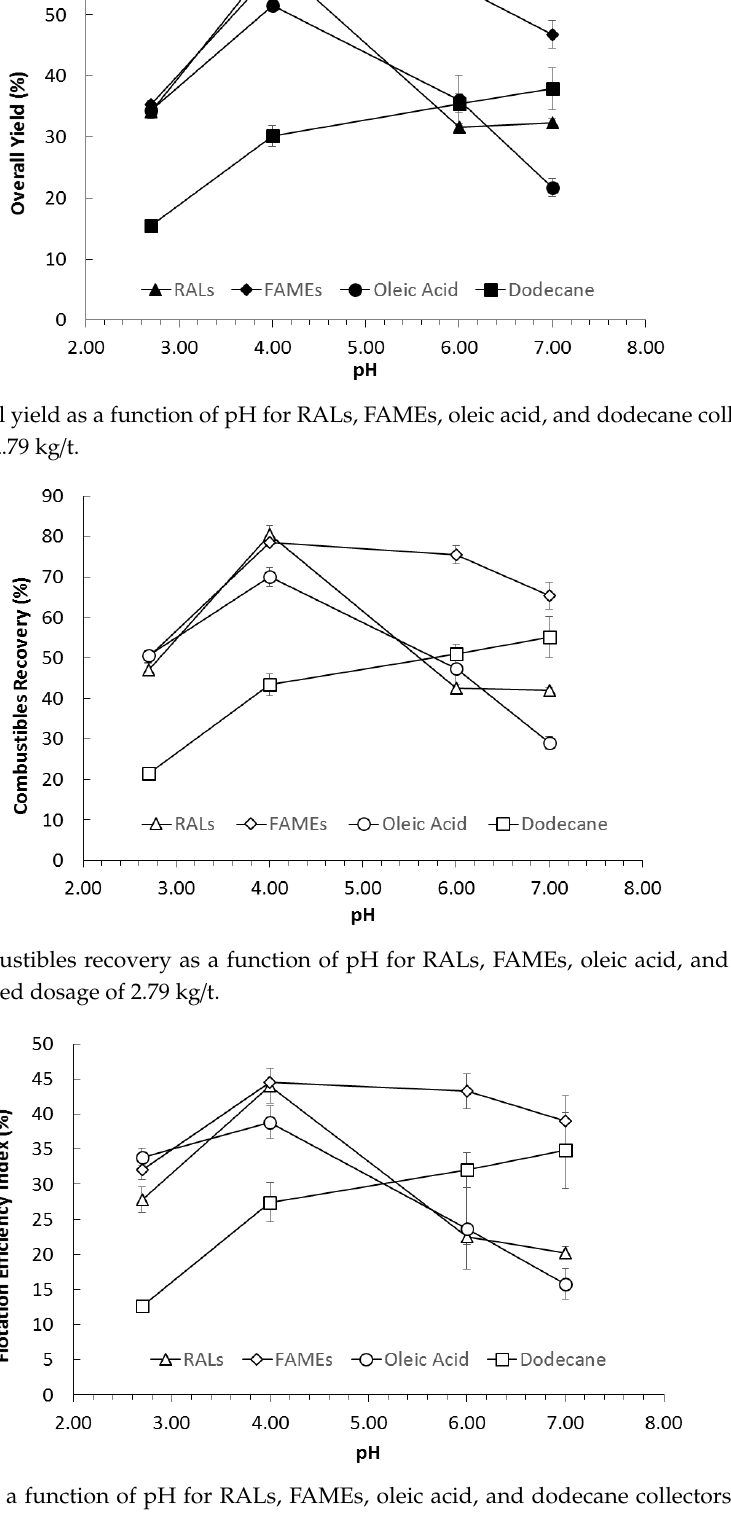
Figure 7. The ( a ) ash and ( b ) sulphur content of the product obtained using RALs, FAMEs, oleic acid, and dodecane collectors at a fixed dosage of 2.79 kg/t.